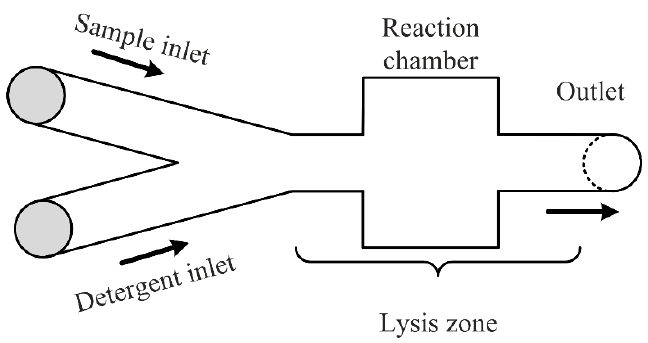
Figure 1. Schematic generalization of a microfluidic device for chemical lysis.